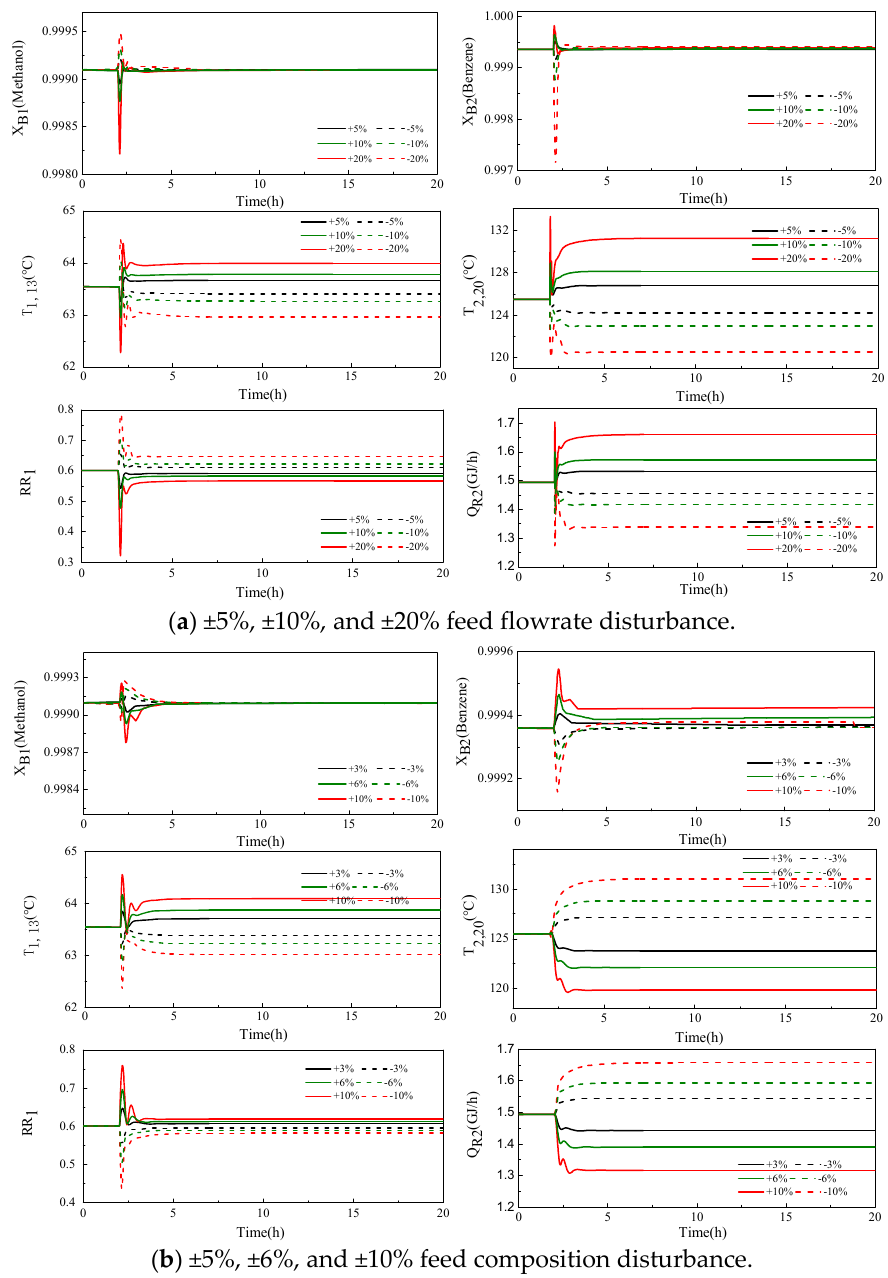
Figure 21. The dynamic responses of control structure CS3.